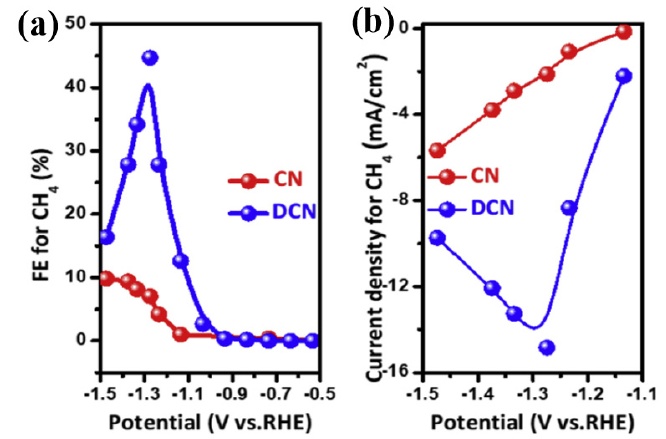
Figure 4. In CO 2 -saturated 0.1 M KHCO 3 , ( a ) CN and DCN produce FE of CH 4 at each potential. ( b ) Comparison of current densities to produce CH 4 ; reprinted with permission from ref [44],